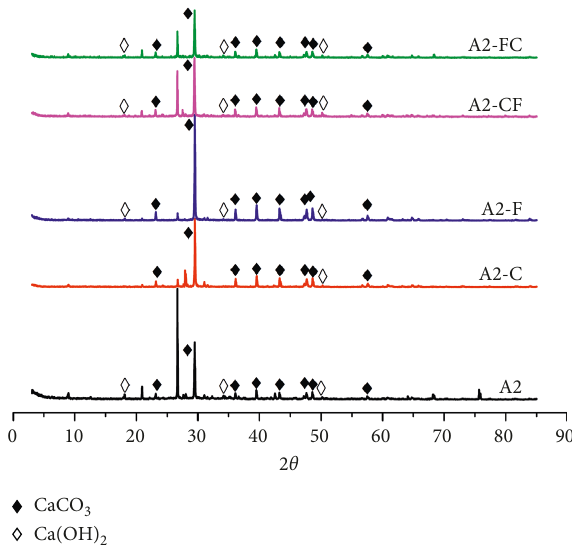
Figure 13: XRD analysis of A2